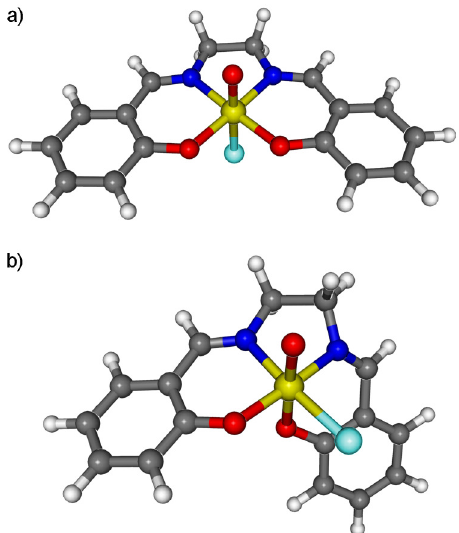
Figure 6. Cis ( a ) and trans ( b ) isomers of oxo-Mn(salen)Cl. In these representations, the carbon atoms are represented in grey, hydrogen in light grey, oxygen in red, nitrogen in blue, chloride in light blue and the manganese atoms as yellow